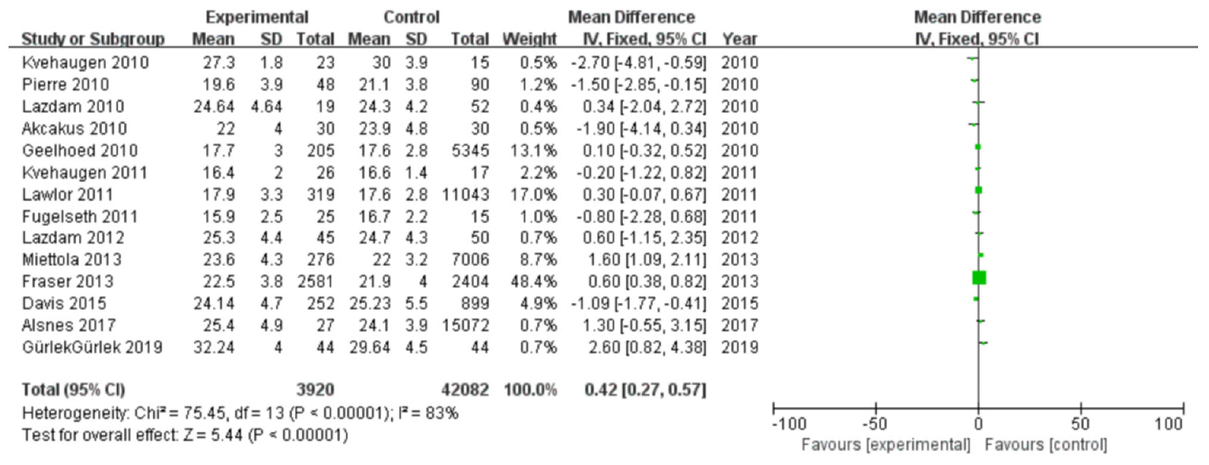
Figure 11. Meta ‐ analysis forest map for BMI of offspring of PE pregnancies. Kvehaugen 2010, [16];